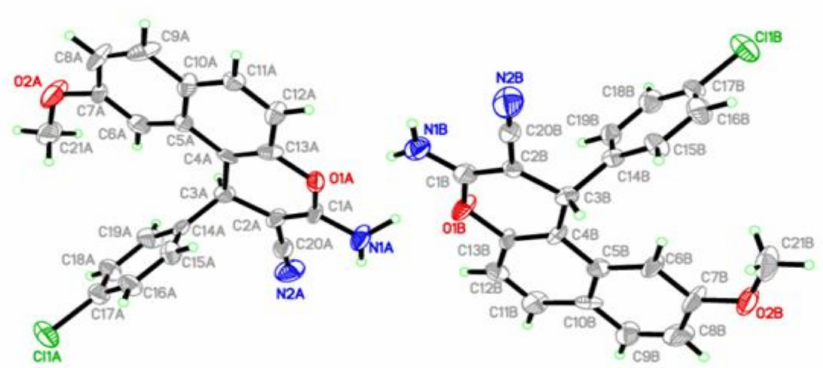
Figure 1. ORTEP diagrams of the titled compound 4 . Displacement ellipsoids are plotted at the 40% probability level for non-H atoms.